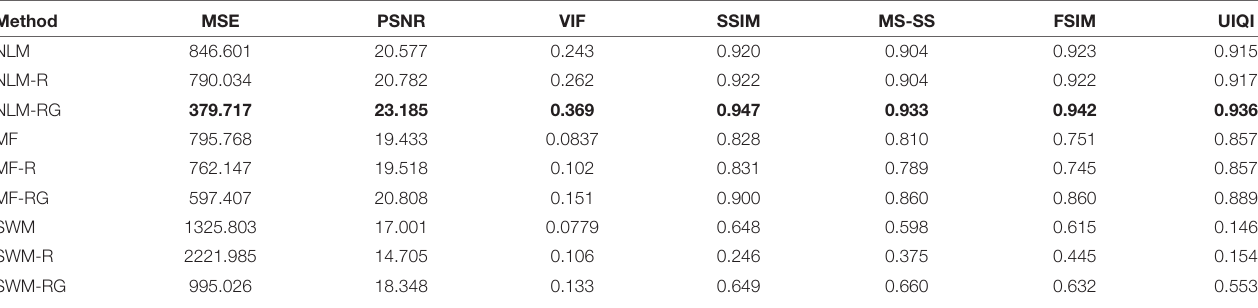
TABLE 4 | Quantitative comparison when adopting different denoising methods in the W-T space.